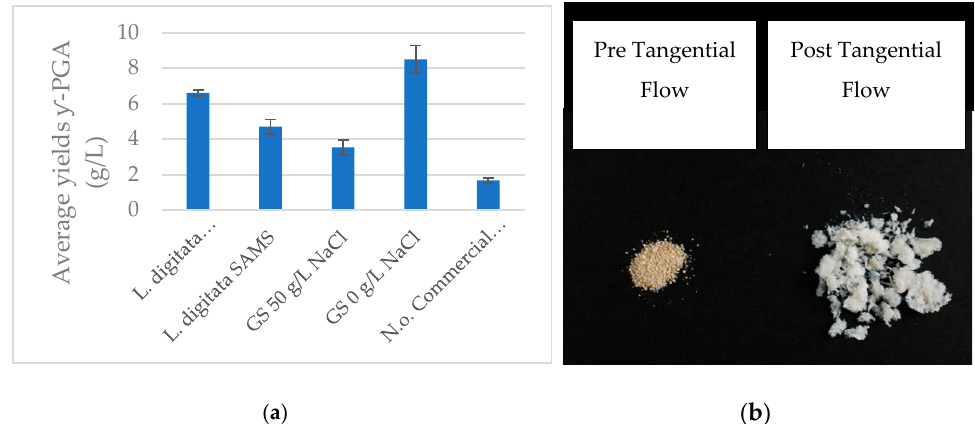
Figure 3. ( a ) Average yields of γ -PGA obtained post-tangential flow with supplemented Laminaria digitata substrate (in flakes from commercial supplier and in powder from Scottish Association for Marine Science), pre-extracted and supplemented Nanochloropsis oceanica media, standard GS media (50 g/L NaCl) and modified GS media (0 g/L NaCl). ( b ) Pre- and post-tangential flow of purified γ -PGA obtained from L.d. commercial substrate. n = 3. Error bars indicate standard error values.